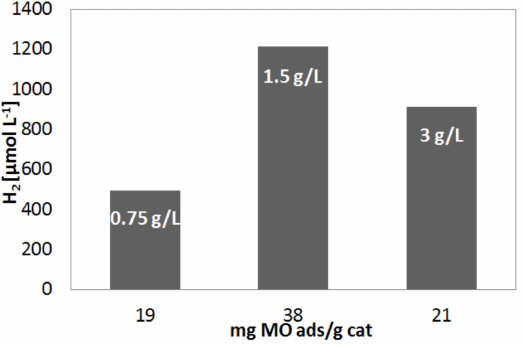
Figure 6. The e ff ect of catalyst dosage on H 2 production after 4 h of UV irradiation time.